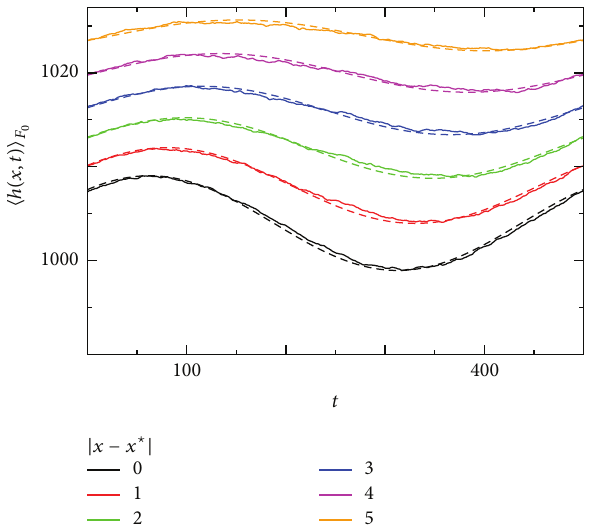
for an 0 , while the 0